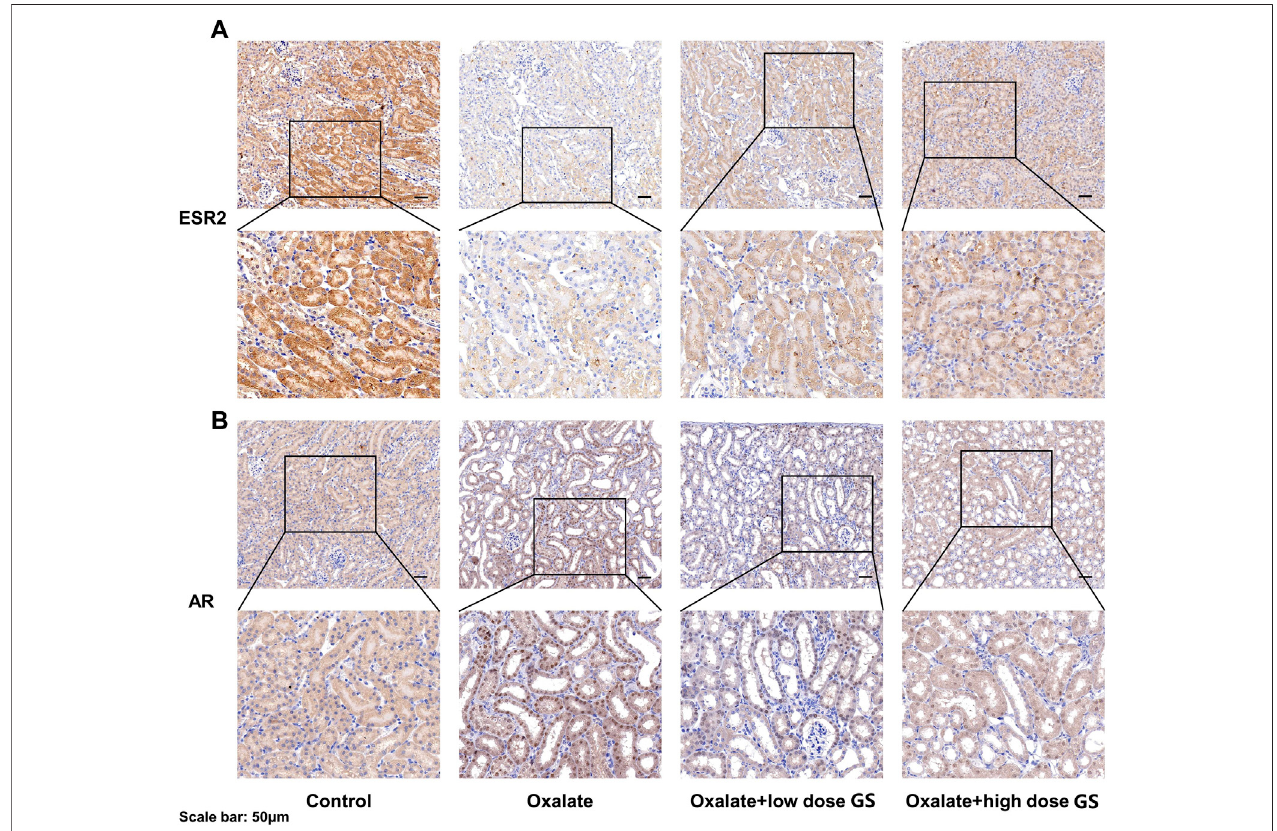
FIGURE 8 | The expression of ESR2 (A) and AR (B) in the renal tissues from the control group, oxalate group, oxalate + low-dose GS group, and oxalate + high- dose GS group detected using IHC staining.